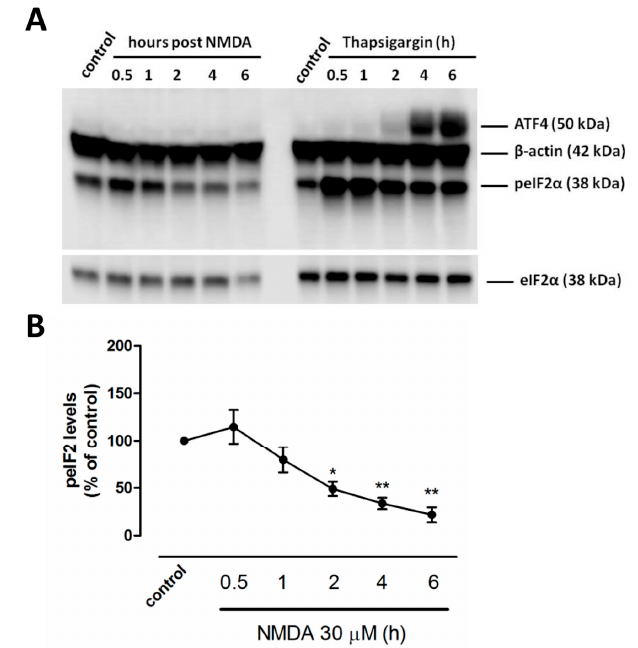
Figure 1. NMDAR activation induces activating transcription factor 4 (ATF4)-independent phosphorylation of eIF2 α at Ser51 (peIF2 α ) dephosphorylation. ( A ) Cells were stimulated with NMDA (30 µ M, 30 min) or thapsigargin (1 µ M, always present) and harvested at indicated time points for immunoblotting of peIF2 α , total eukaryotic initiation factor 2 (eIF2 α ), ATF4 and β -actin. ( B ) Quantification of peIF2 α levels at indicated time points after NMDA treatment. Data represent normalized means ± SEM of three independent experiments. * p < 0.05; ** p < 0.01 compared with untreated cells (control), one-way ANOVA followed by Bonferroni´s post hoc test.